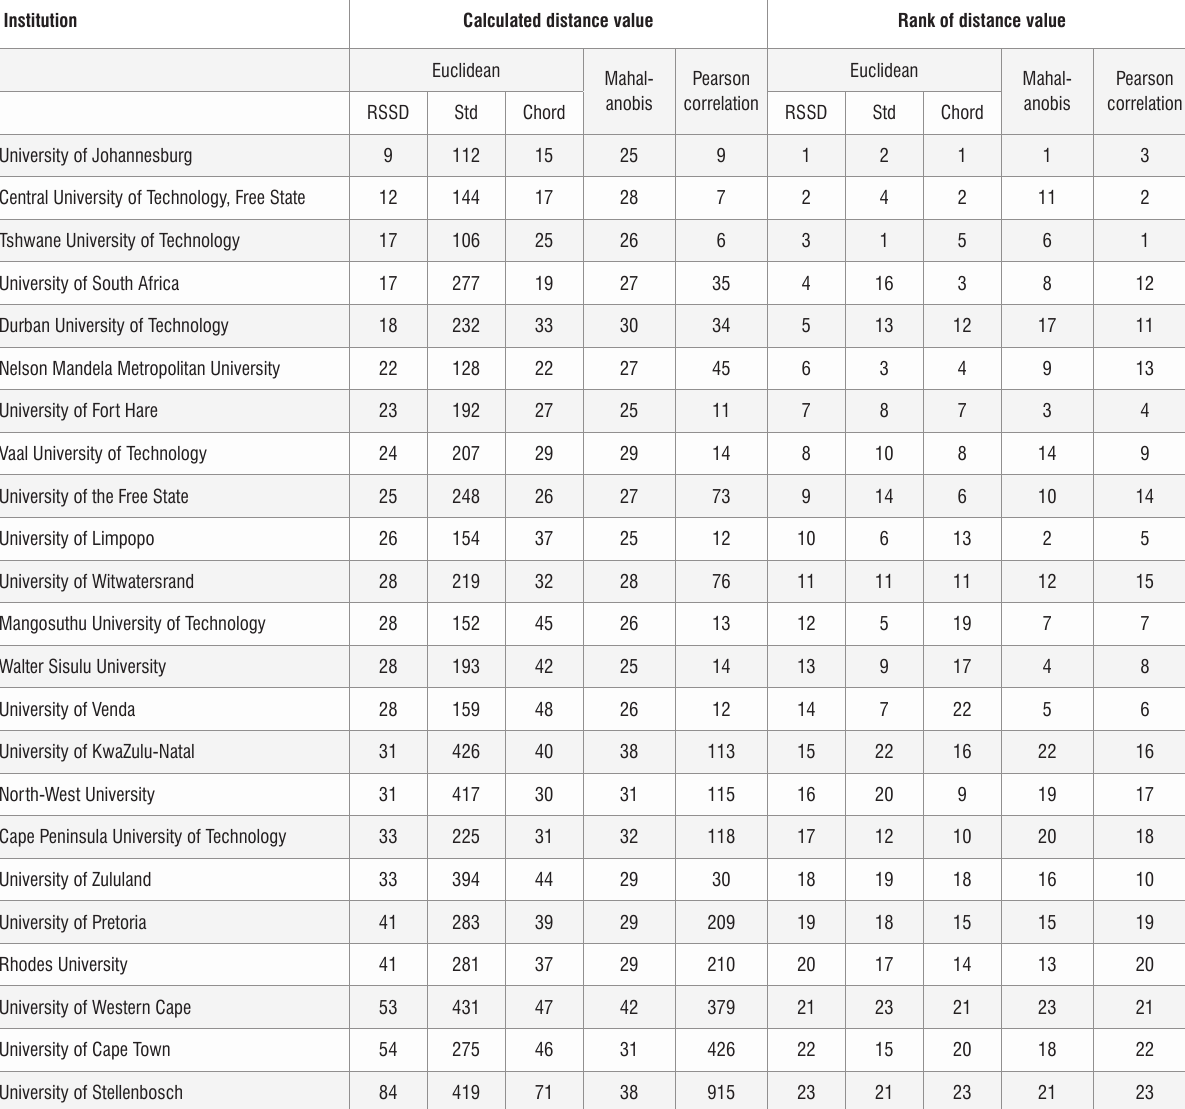
Institution Calculated distance